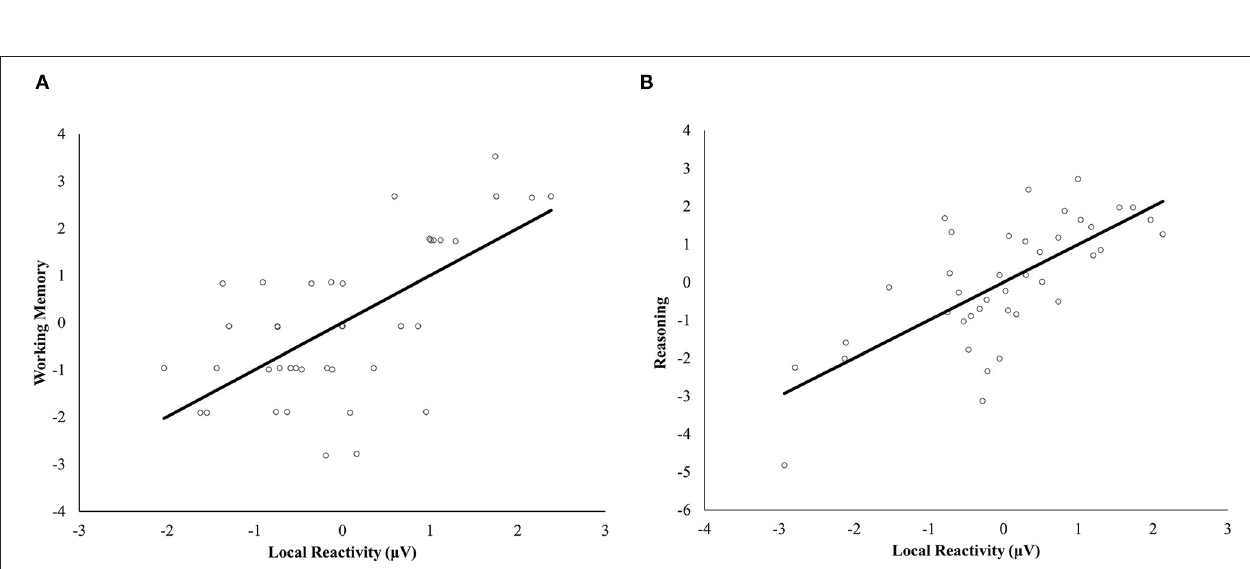
Frontiers in Psychology |